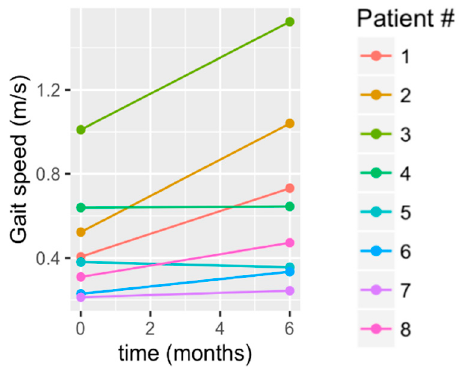
Figure 5. Change in gait speed from baseline to 6 months.